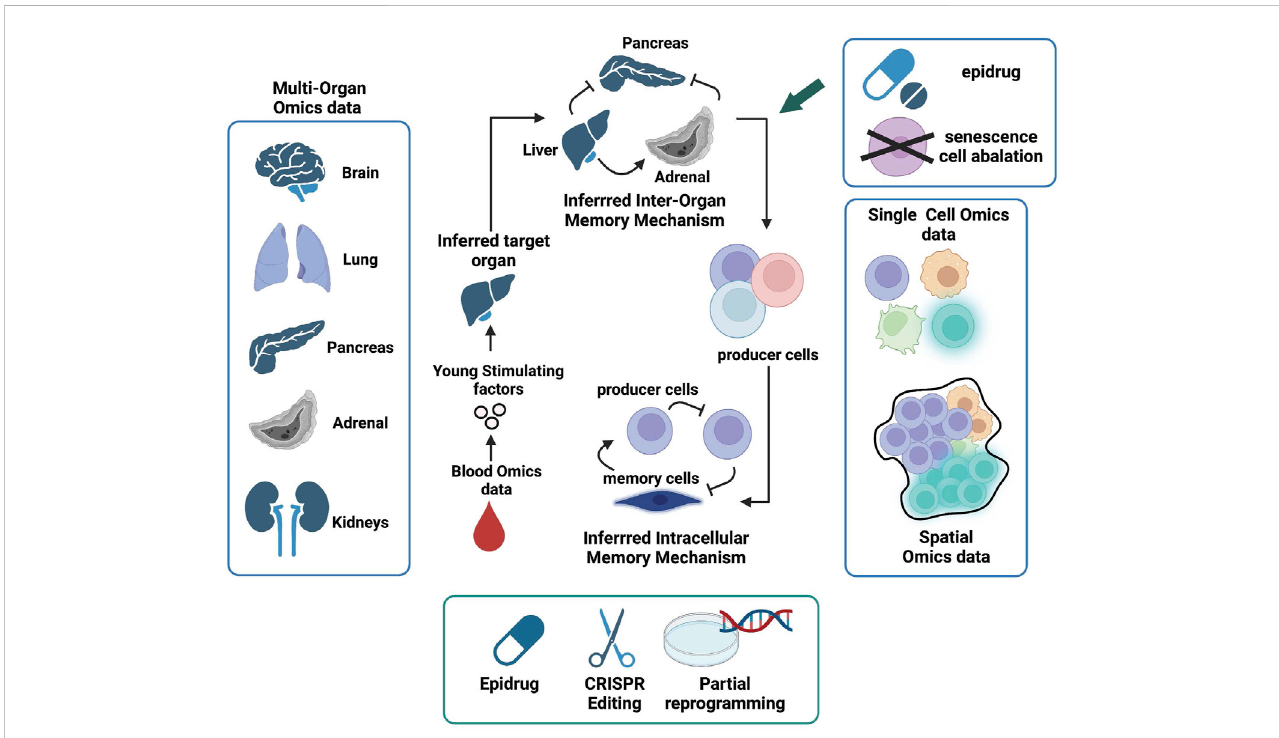
FIGURE 4 Manifold Epigenetic Engineering (MEE). Schematic representation of key omic datasets and strategies to achieve MEE and invigorate whole body regenerative health. The fi rst MEE step is to identify circulating systemic factors present in higher levels in young but decreased or absent in aged individuals. Next, multi-organ single-cell omics and spatial data can be used to identify cells that produce “ young ” factors and infer their communication networkswithin cellular niches using knowledge from receptor-ligand interactions. Organs that produce “ young ” factors and are also involved in positive feedback interactionsaredeemedmemoryenforcersandwillbeprioritizedastargetorgans.Celltypesthatmediatepositivefeedbacksinthecommunication websare deemed memory enforcers and will be prioritized as target cells. Both target organs and cells will be subjected to engineered interventions (senescence cell ablation, drug intervention, chromatin state editing, and partial reprogramming) in aged individuals to help restore regenerative